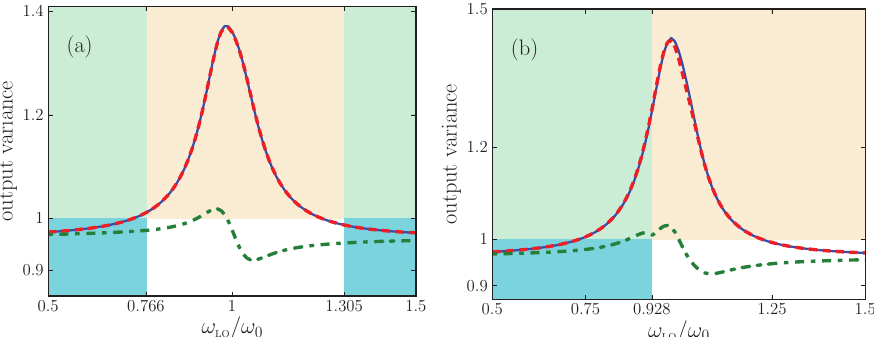
Figure 7. (Color online) For squeezed light incident at an angle of θ = 30 ◦ onto a loss-compensated multilayer metamaterial, a comparison of the predicted variances (44) as would be measured in balanced homodyne detection at a detection angle of also 30 ◦ . The metamaterial and the input states are described in Figure 6. Predictions with exact multilayer theory (blue solid line) are compared with the quantum optical effective-index theory (green dash-dotted) and quantum optical effective- medium theory (red dashed), for s -polarized input states of light in panel ( a ) and for p -polarization in ( b